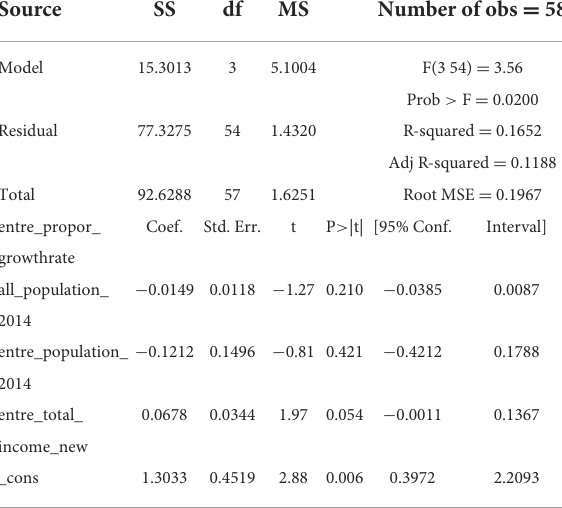
TABLE 8 The analysis of the correlation between the growth rate of the proportion of entrepreneurial population and the difference between entrepreneurial income and community per capita income under the condition of large income.